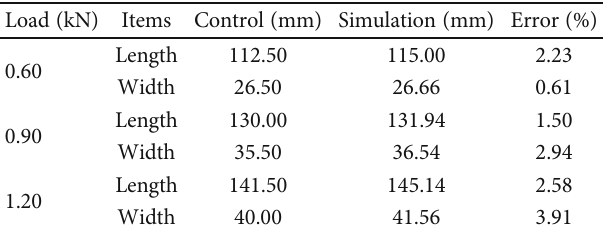
Figure 7: Comparison of contact patches for 2.75-18 tires at di ff erent loads: (a) 0.60kN; (b) 0.90kN; (c) 1.20kN. Table 2: Contact patch dimensions for 2.75-18 tires at di ff erent